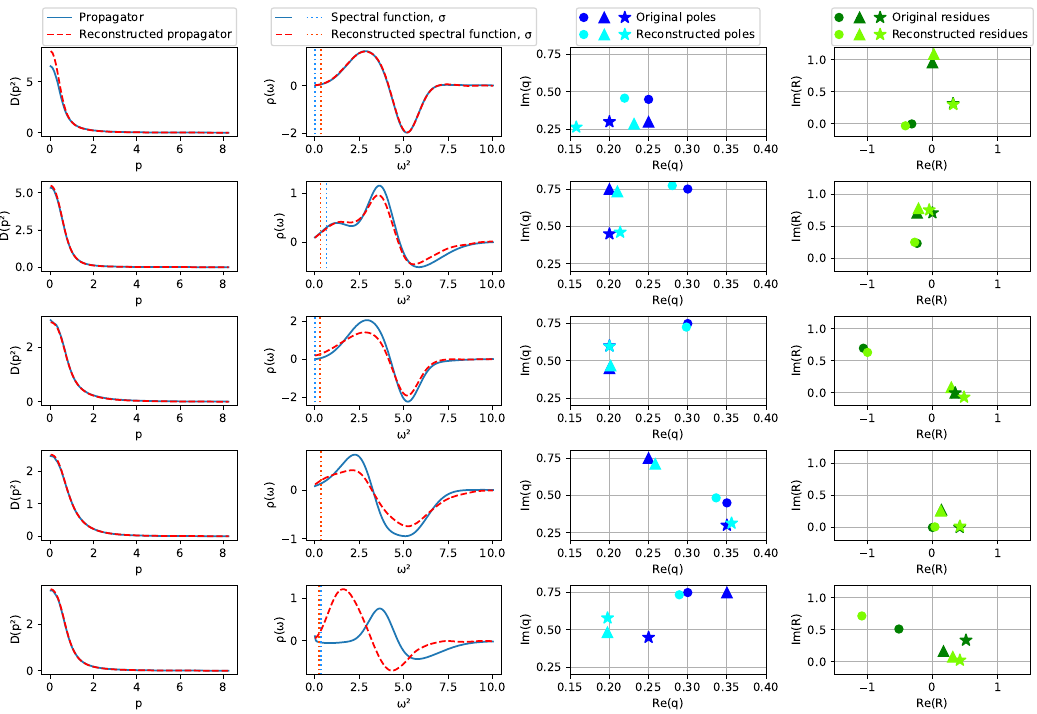
Figure 2: A selection of spectral functions, sorted according to their MAE: the best (top row), the 25th percentile, the median, the 75th percentile, and the worst (bot- tom